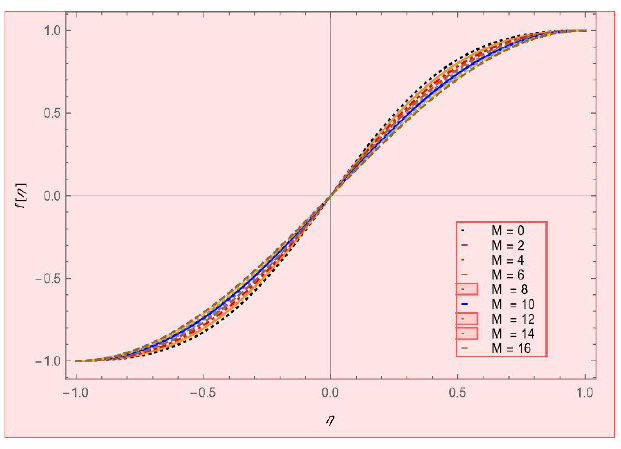
Figure 7. Axial velocity profile for 𝜑 1 = 𝜑 2 = 0.01, 𝛼 = 1, 𝑅𝑒 = −1.